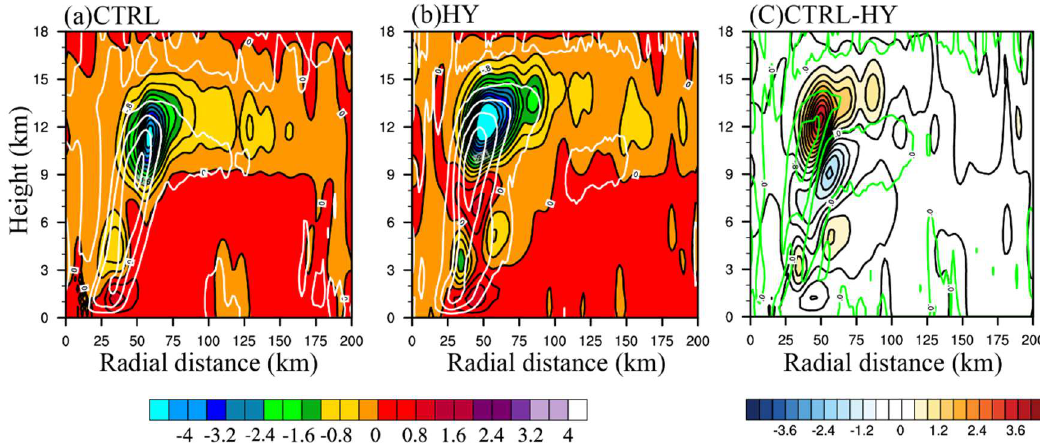
Figure 6. Height–radius cross-sections of the azimuthal mean vertical accelerated dw / dt (color shaded, m s − 1 h − 1 ) and vertical winds (green contours, m s − 1 ) for ( a ) CTRL, ( b ) HY, and ( c ) CTRL-HY averaged between 84 and 96 h. The vertical motion is shown with intervals of 0.4 m s − 1 and the outer-most contour is 0 m s − 1